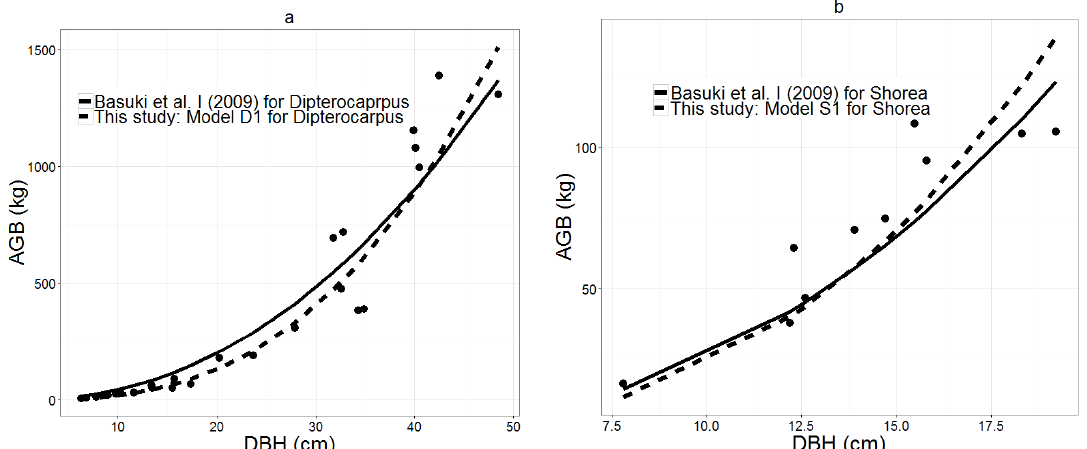
Figure 7. Predictions of AGB by the DBH-based genus-specific models developed in this study and those developed for dipterocarp forest of Indonesia for ( a ) Dipterocarpus and ( b ) Shorea genera. Table 8. Percent bias, RMSPE, and MAPE for the selected genus-specific models and genus-specific equations for dipterocarp forest of Indonesia.